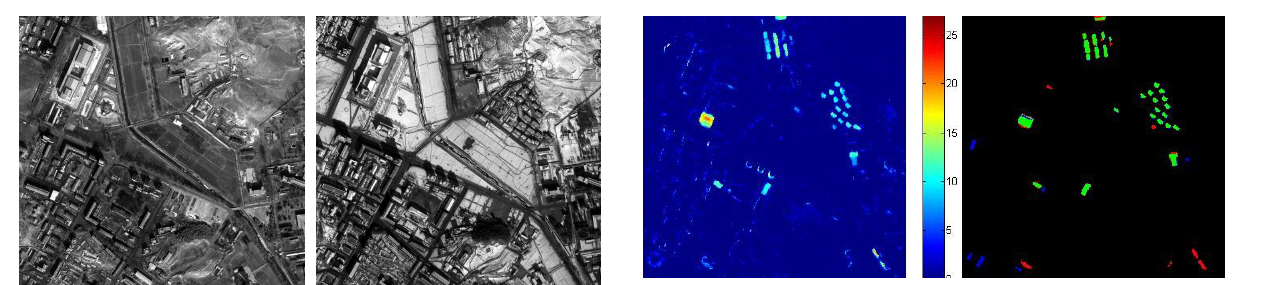
Figure 10: Detected changes in the Ikonos stereo DEMs of Dong- An, left: change probability (in %), right: change mask (green: true detected changes, blue: missed changes, red: erroneously detected changes)